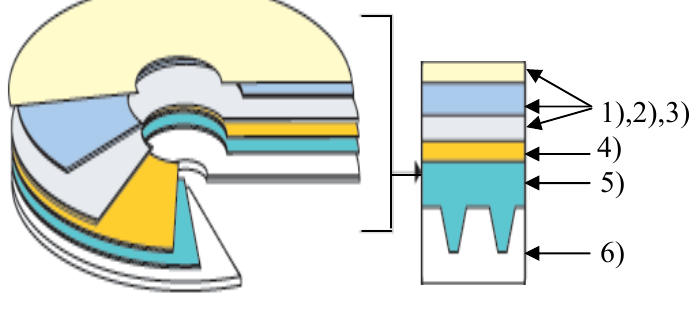
Figure 1. Structure of a CD-R: 1), 2) and 3) protective polymer layers; 4) reflective